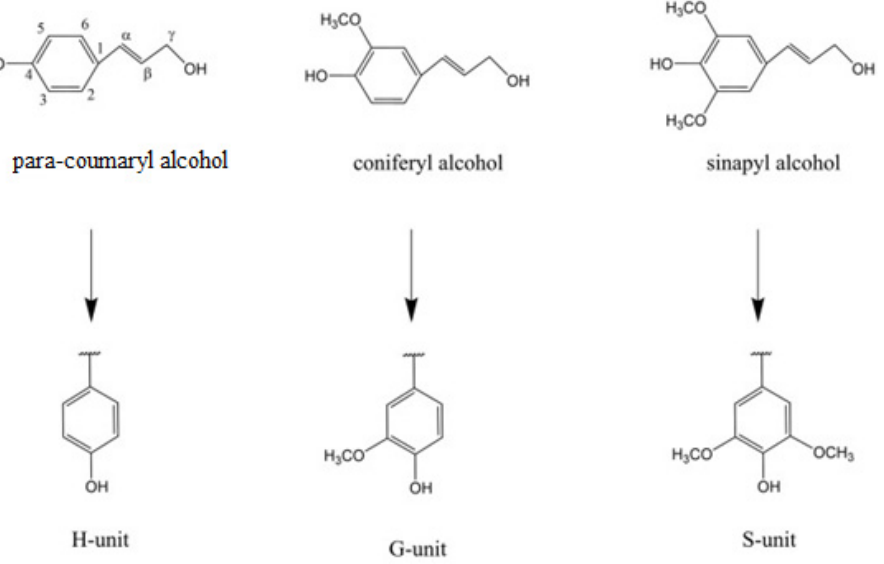
Figure 1. Structure of three lignin monomer alcohols. Numbers represent position of carbon in benzene ring while Greek letters represent distance of carbon atoms in side chain from ring C1 [2].